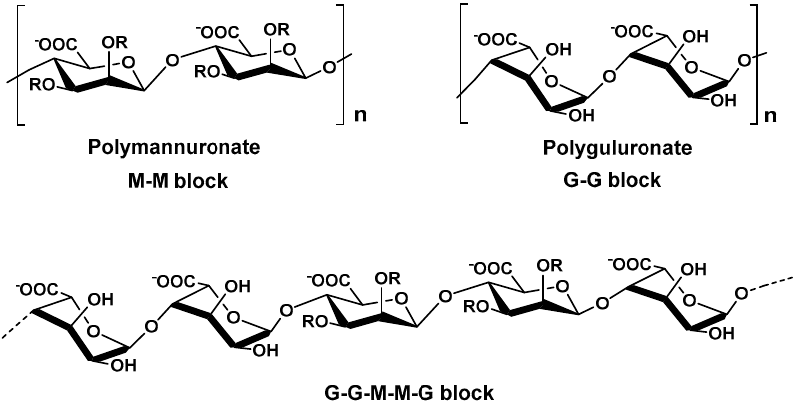
Figure 3. Mains structure of alginates. From algae with R = H and from bacteria with R = H or COCH 3 (acetyl group).